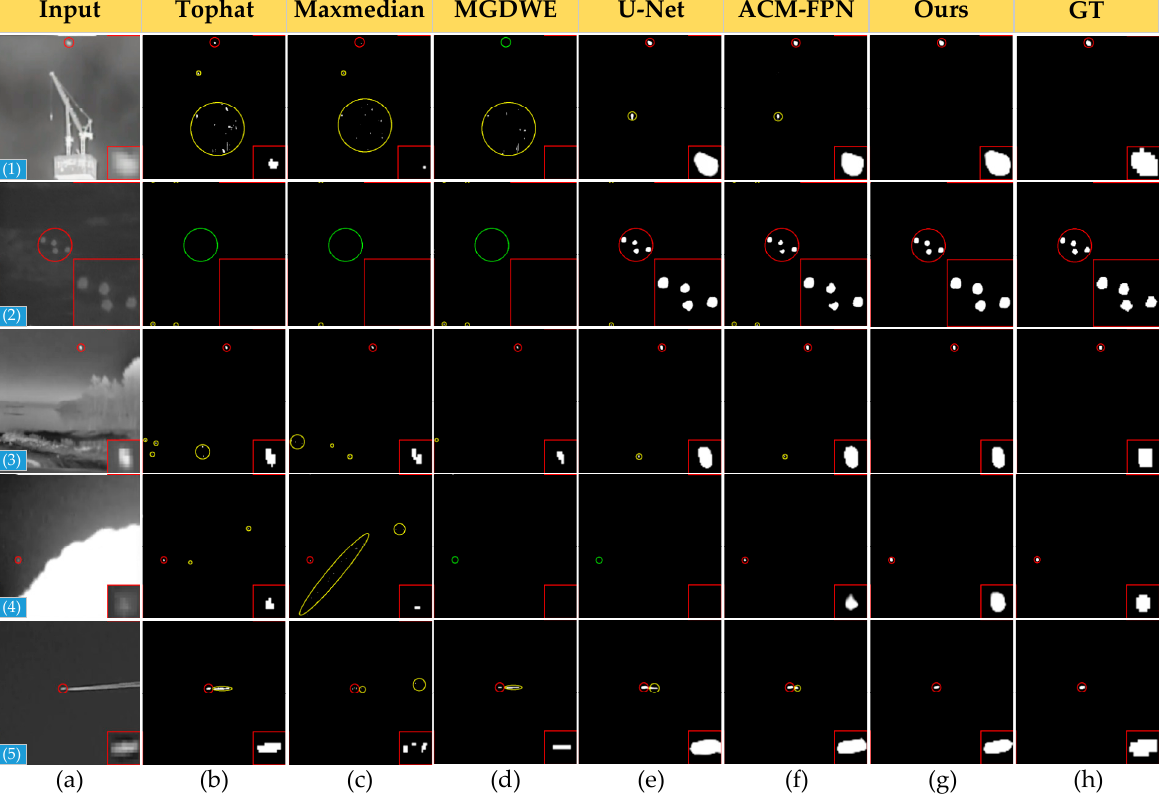
Figure 9. Qualitative results obtained with different infrared target detection methods.